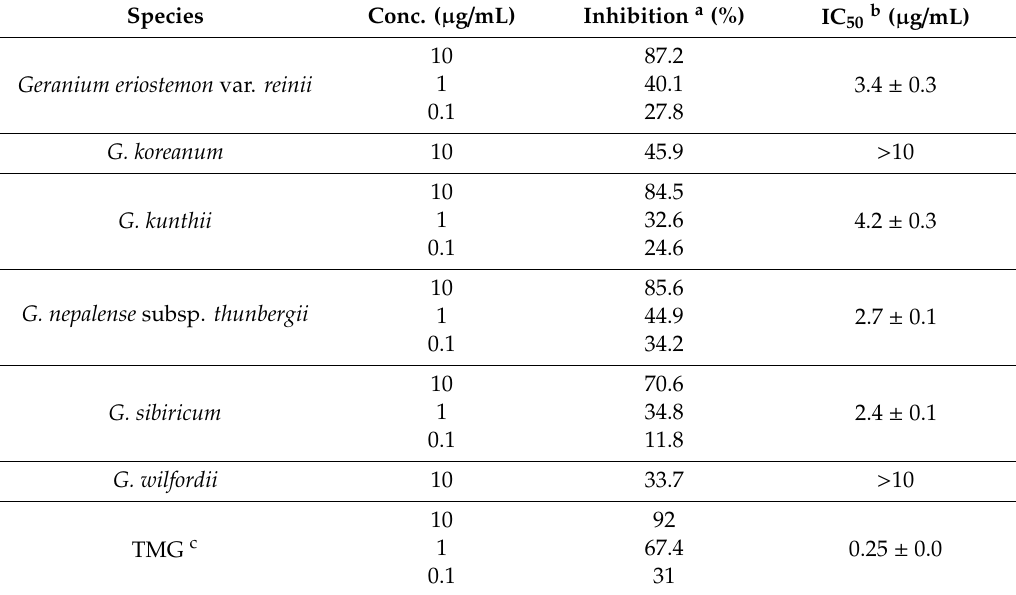
Table 3. IC 50 values of MeOH extracts of the Geranium species.